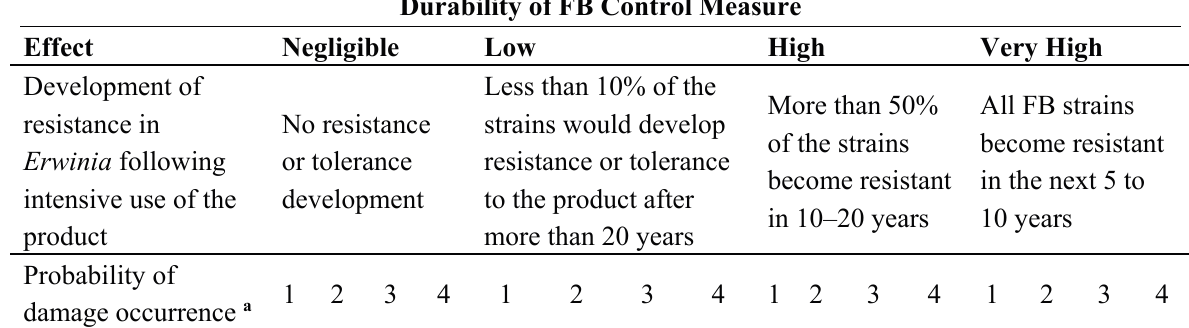
Table 1. Example of the assessment of durability of the fire blight (FB) control measure investigated.